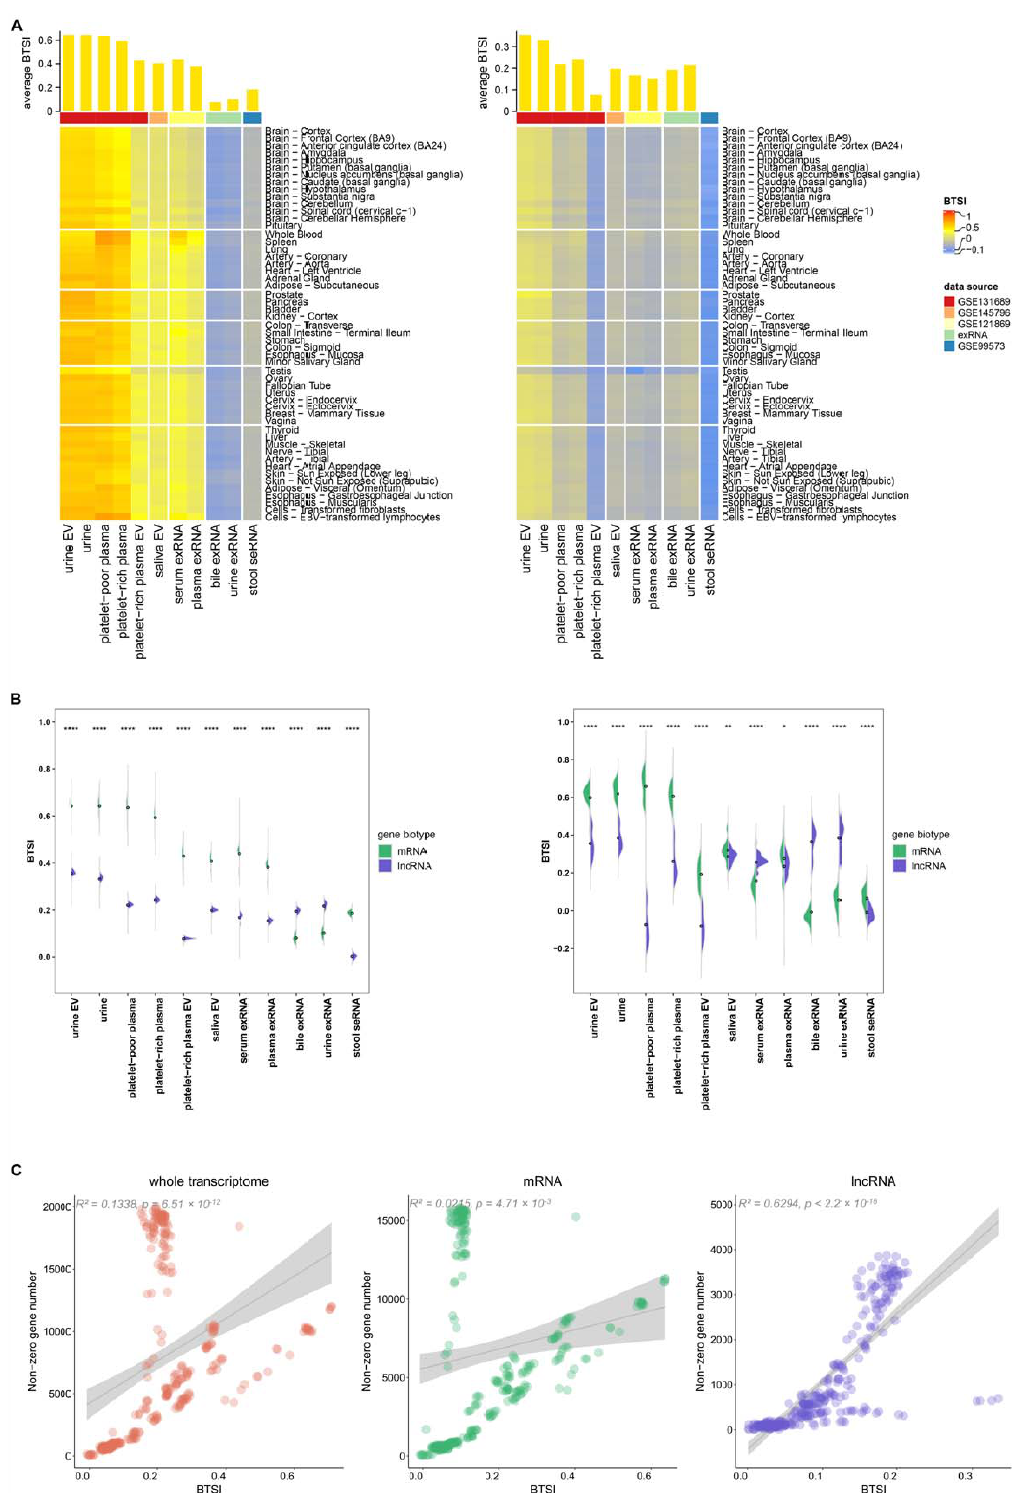
Figure 3. Biofluid–tissue correlation in mRNA and lncRNA view. ( A ) The bar plot at the top and heatmap at the bottom separately describe the BTSI levels between biofluids and all human tissues, as well as each human tissue in mRNA (left) and lncRNA (right). ( B ) The half violin plots show the comparison results of the BTSI levels between BF-mRNAs, T-mRNAs, BF-lncRNAs and T-lncRNAs before (left) and after correction (right); the dot represents the corresponding average BTSI value. ****, ** and * are used to label the p -values of the t -test results ( p -value < 0.0001, p -value < 0.01, p -value < 0.05). ( C ) The scatter plot demonstrates the correlation between BTSI and the non-zero gene number of the biofluid samples in the whole transcriptome (left), mRNA (middle) and lncRNA (right). The R 2 and p -values of the linear regression results are